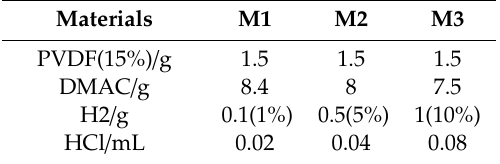
Table 1. The proportion of the materials in the membrane solution.